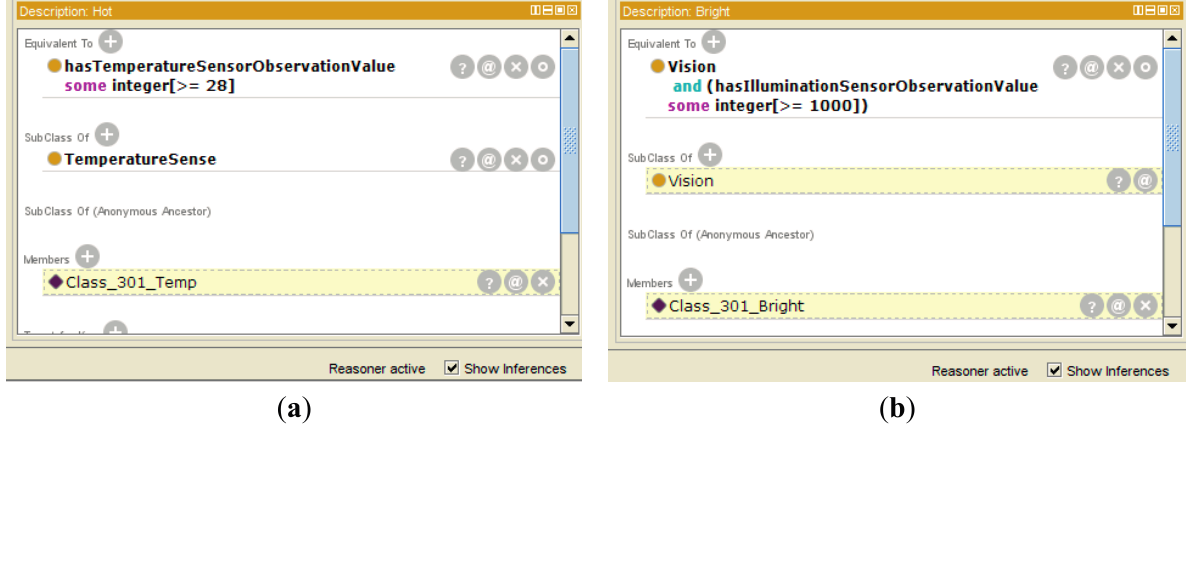
Figure 10. Inferred ontology model. ( a ) Class_301_Temp instance; ( b ) Class_301_Bright